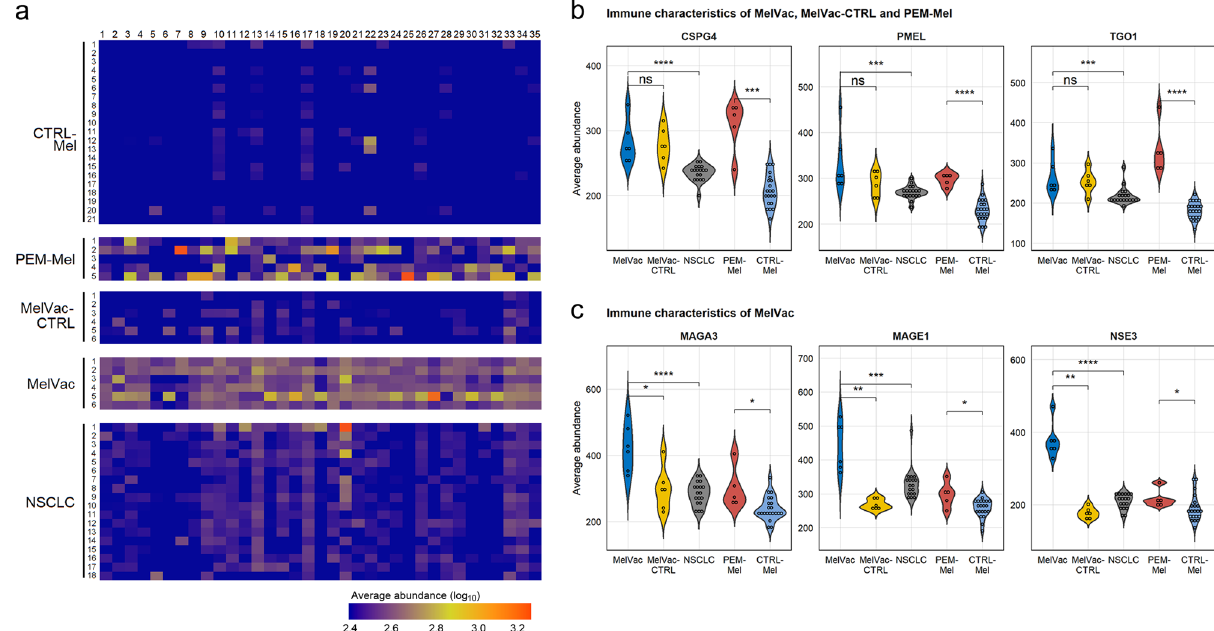
Fig. 3 Individual-speci fi c immunopro fi les of antibody response to melanoma-associated antigens. a Heatmap showing the antibody response to melanoma-antigens in patients with cancer and in the controls. Log 10 -transformation of the average abundance of the IgG-bound peptides containing epitopes with 100% identity to the indicated proteins are depicted. Value range ≤ 2.4 and ≥ 3.3 is provided for better visual representation. Group names of samples are depicted on the y- axis, individuals shown in numbers. x- axis indicates different melanoma-associated antigens (a total of 35 proteins) shown in Supplementary Table 3 and Supplementary Data 3. b , c Violin plots showing the average abundance of IgG-bound peptides containing epitopes with 100% identity to the speci fi c proteins (shown above each graph, Supplementary Data 4) from panel a across study sub-cohorts. Two-sided Wilcoxon Rank Sum test, ns p > 0.5, * p < 0.05, ** p < 0.01, *** p < 0.001, **** p < 0.0001, p -values not adjusted for multiple comparisons. CTRL-Mel – healthy controls for melanoma group ( n = 21, all individuals older than 45 years); PEM-Mel – melanoma patients receiving pembrolizumab treatment ( n = 5); MelVac-CTRL – paired samples of MelVac group taken before vaccination ( n = 6); MelVac – NSCLC patients who received MelCancerVac ® vaccine ( n = 6); NSCLC – non- small cell lung cancer patients ( n =